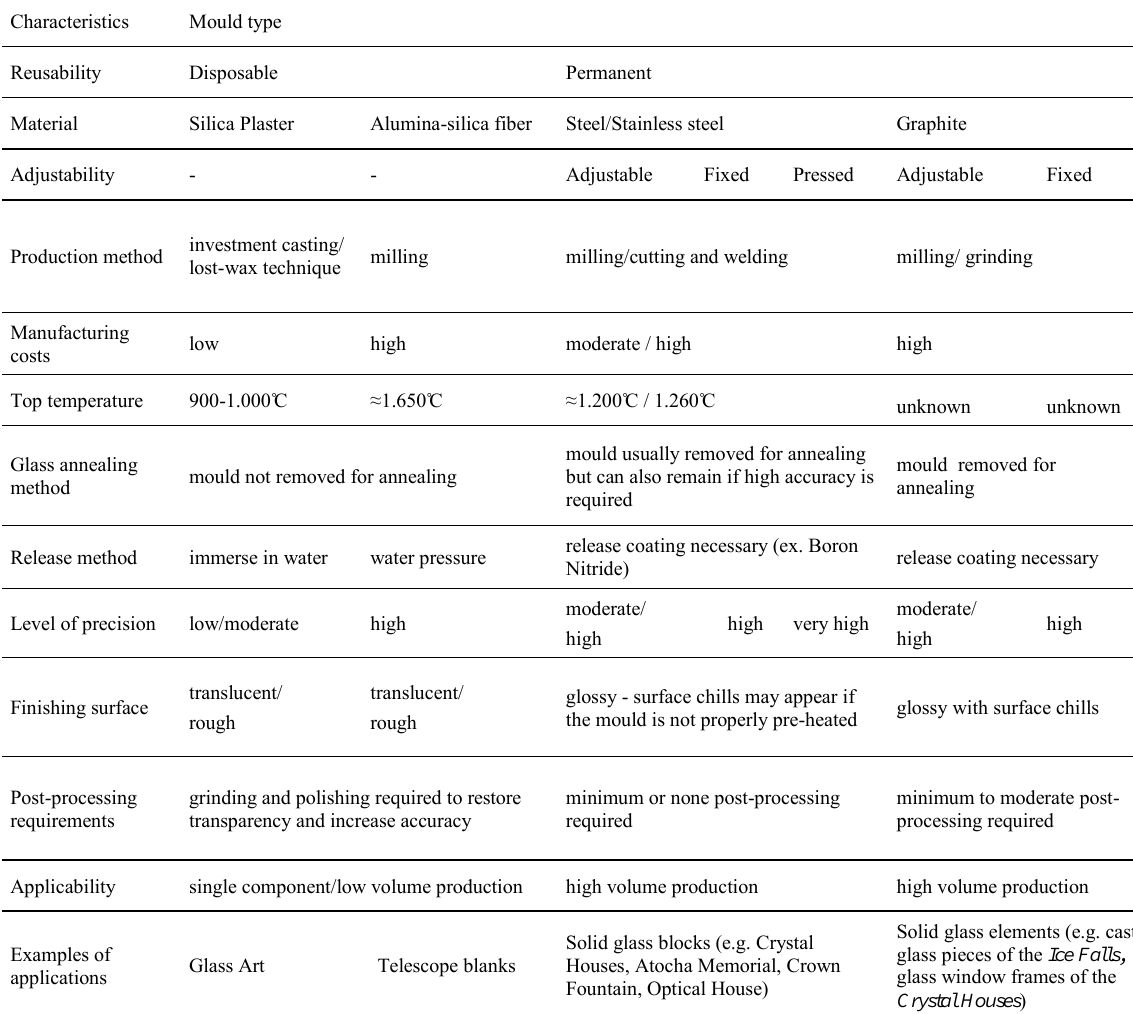
Table 1: Characteristics of prevailing mould types for glass casting derived from (Oikonomopoulou